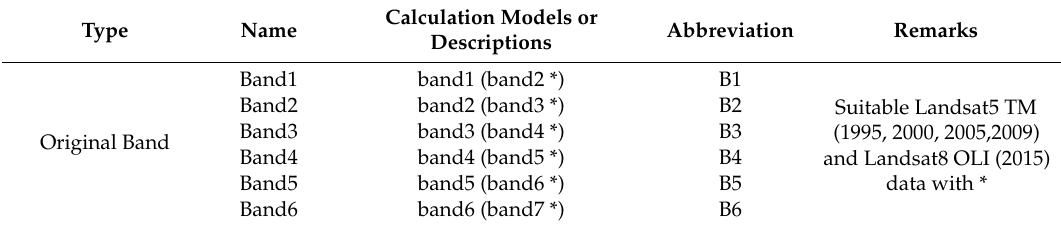
Table 3. Remote sensing variables of land use